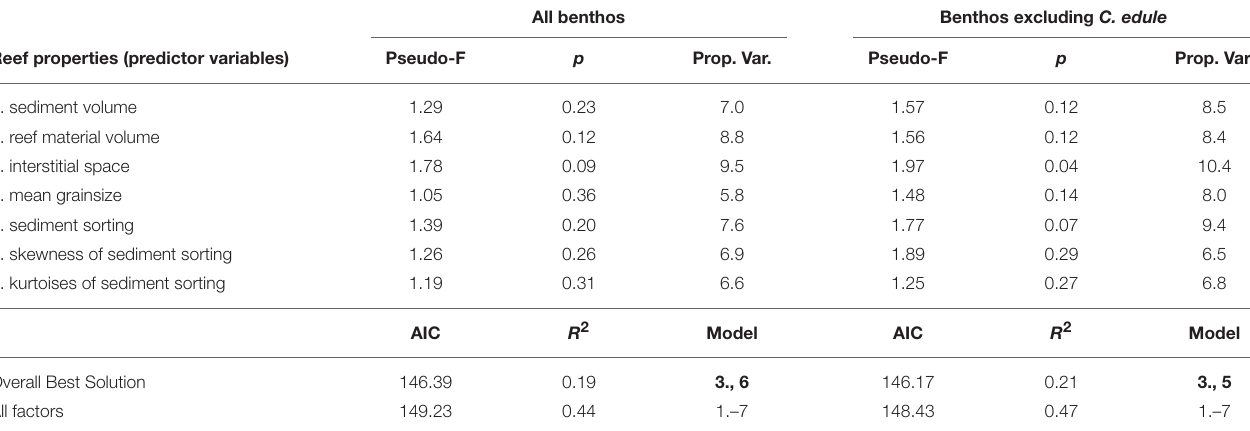
FIGURE 5 | Most abundant species and taxonomic groups in experimental reef-units. From outside to inside: rock-reefs ( n cockles ( n 4). Abundances for materials based on mean densities per reef unit. =